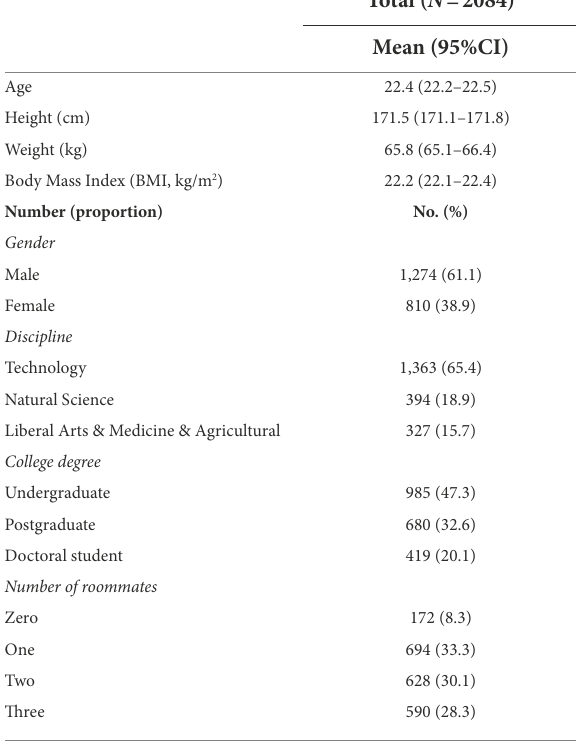
TABLE 1 Participants’ demographic